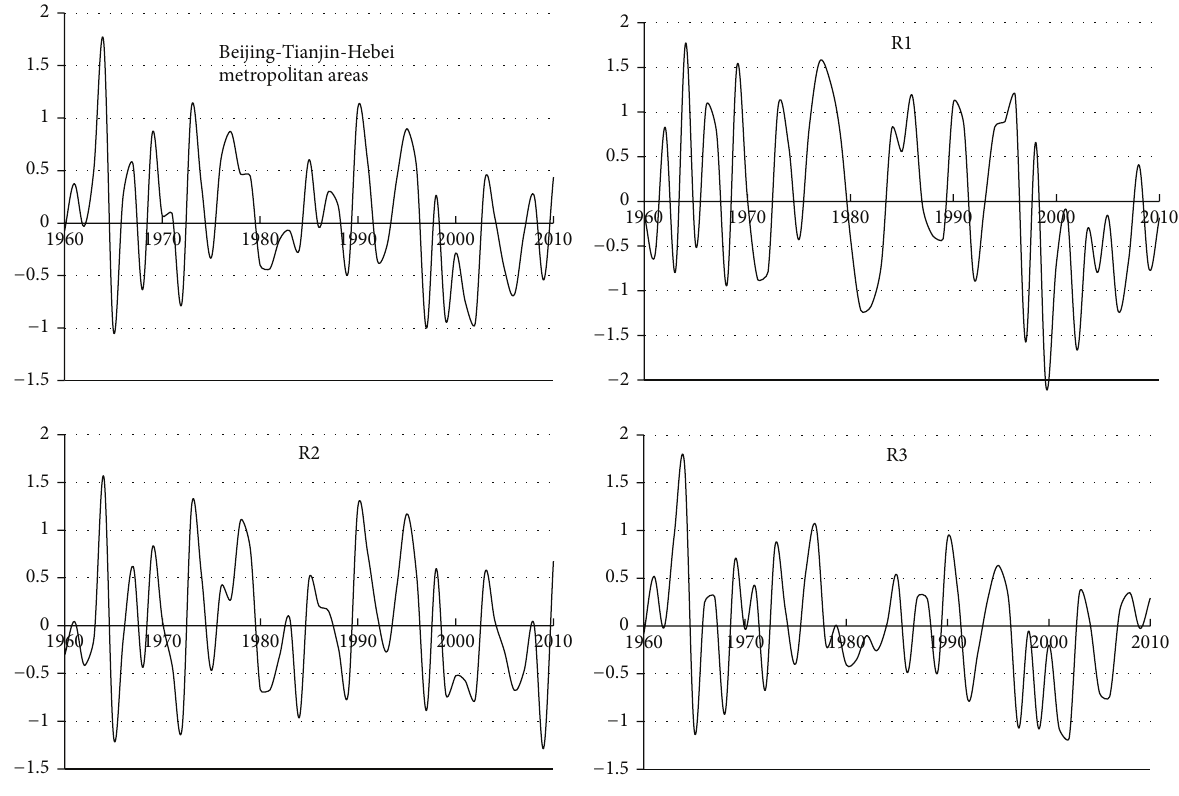
Figure 10: Time series of RDI-12 for BTHMA and three subregions.